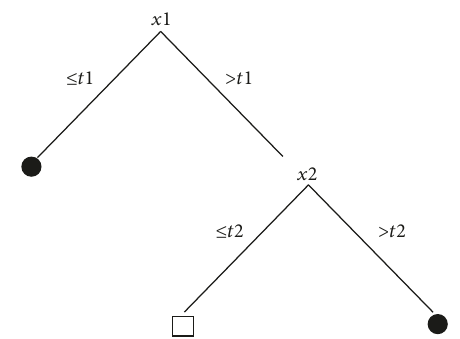
Figure 4: A shallow decision tree with two splitting nodes. Three rules are obtained from the paths between the root and the leaves.